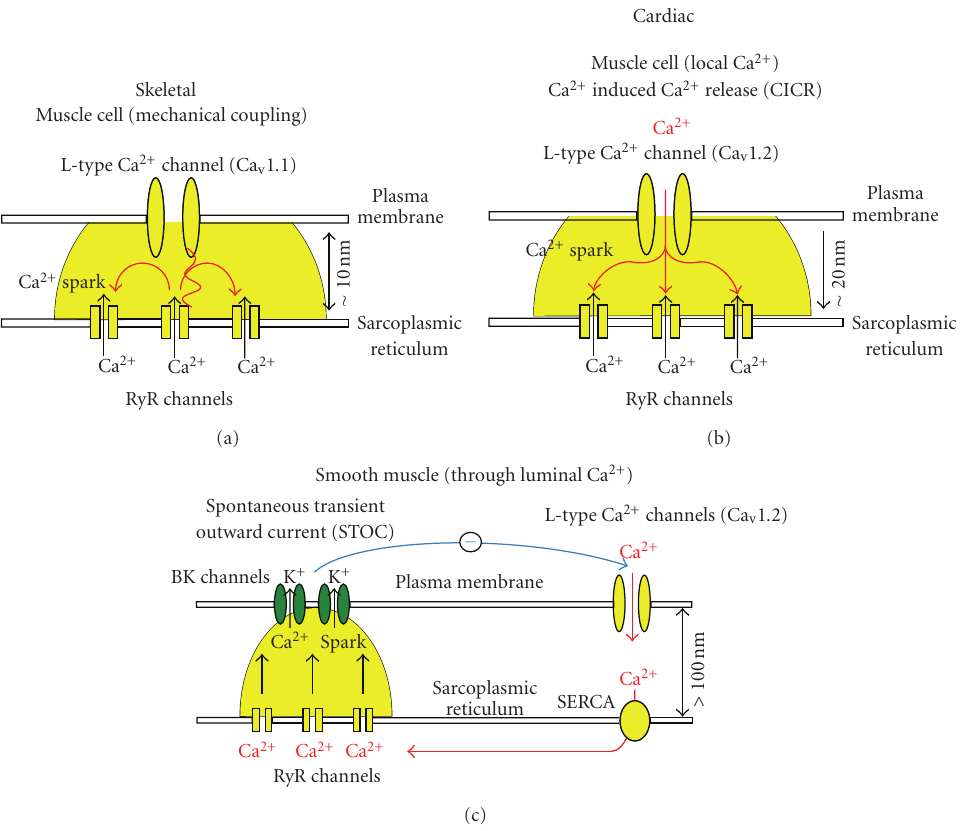
Figure 2: Control of calcium sparks by voltage-dependent L-type calcium channels . (a) Ca 2+ entry from extracellular space is not required for calcium release in skeletal muscle. Charge movement within Ca v 1.1 activates RyR1 channel via a direct physical interaction. Ca 2+ e ffl ux from SR through the opened RyR1 channel activates nearby RyR (RyR3) channels via calcium-induced calcium release (CICR). (b) In cardiomyocytes Ca v 1.2 mediates influx of extracellular Ca 2+ into cytosol. Ca 2+ then binds to and activates RyR2 channels via CICR. (c) Triggering of calcium sparks is not controlled by rapid, direct cross-talk between Ca v 1.2 channels and RyRs in smooth muscle cells in contrast to cardiac and skeletal muscle cells. Instead, Ca v 1.2 channels contribute to global cytosolic [Ca 2+ ], which in turn influences luminal SR calcium and thus calcium sparks. SERCA: sarco / endoplasmic reticulum calcium ATPase, BK: big conductance calcium-activated K +